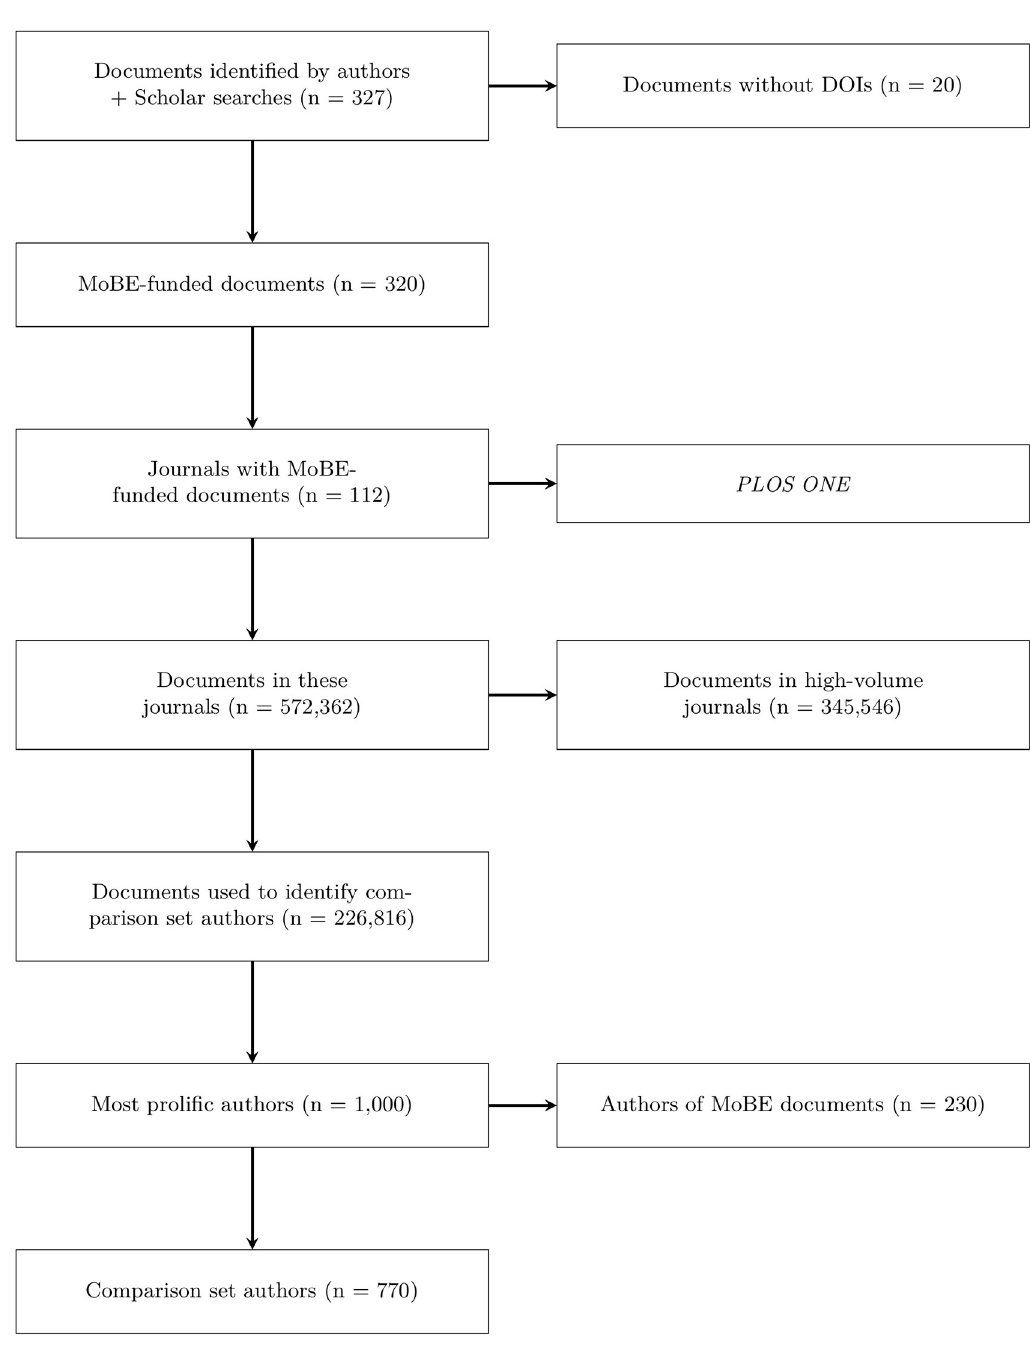
Fig 2. Flow diagram for comparison set